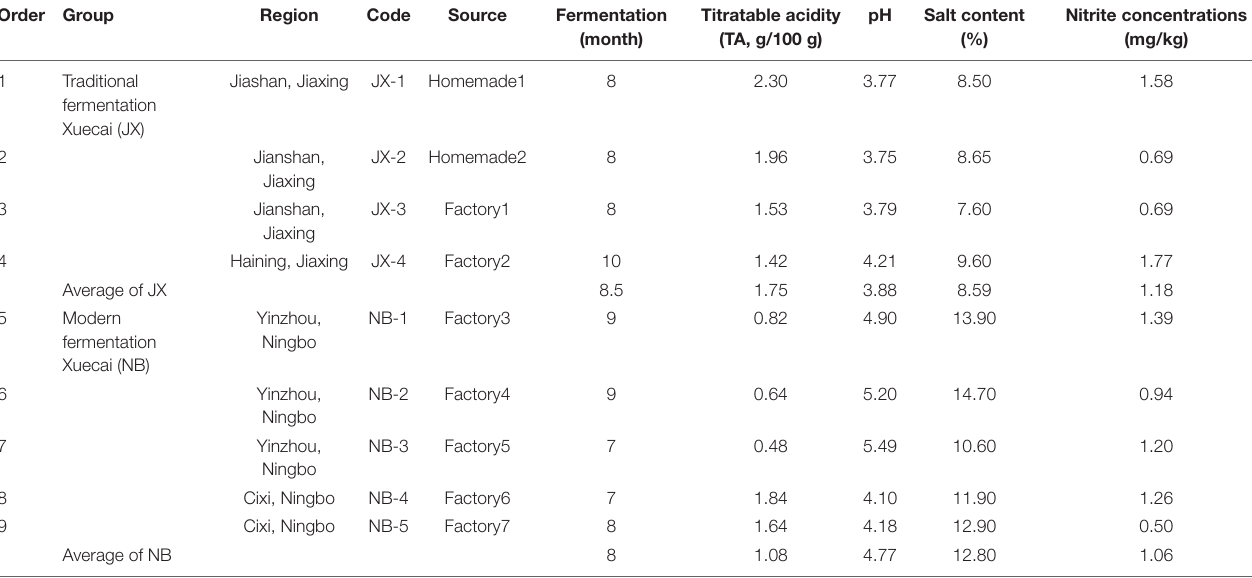
TABLE 1 | Physicochemical properties between traditional fermentation Xuecai and modern fermentation Xuecai. Order